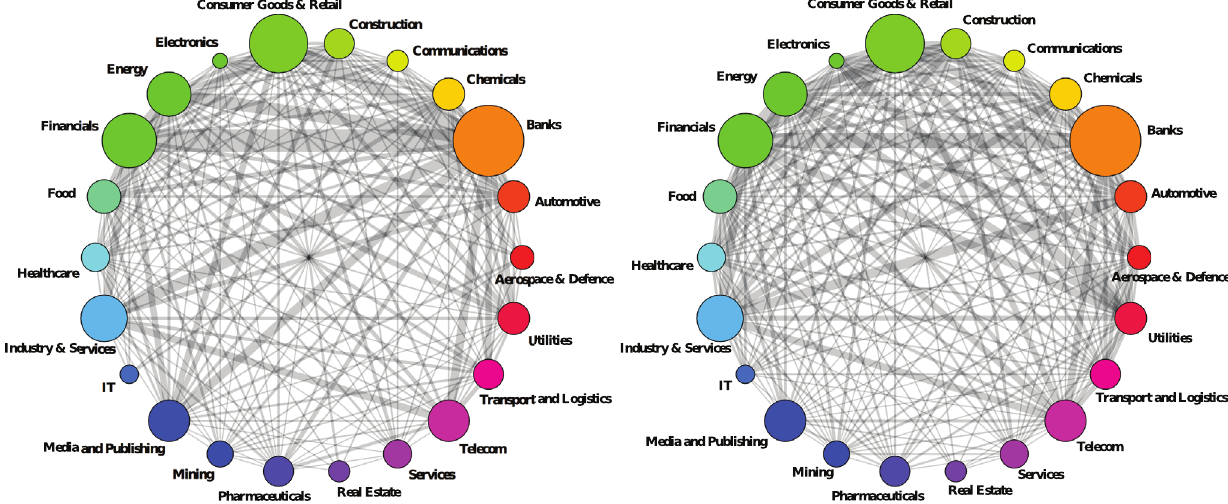
Figure 2. Board interlocks among sectors in 2005 (Left) and 2010 (Right). The size of a node is proportional to the square root of the number of companies in that sector, the thickness of an edge is proportional to the number of interlocks it